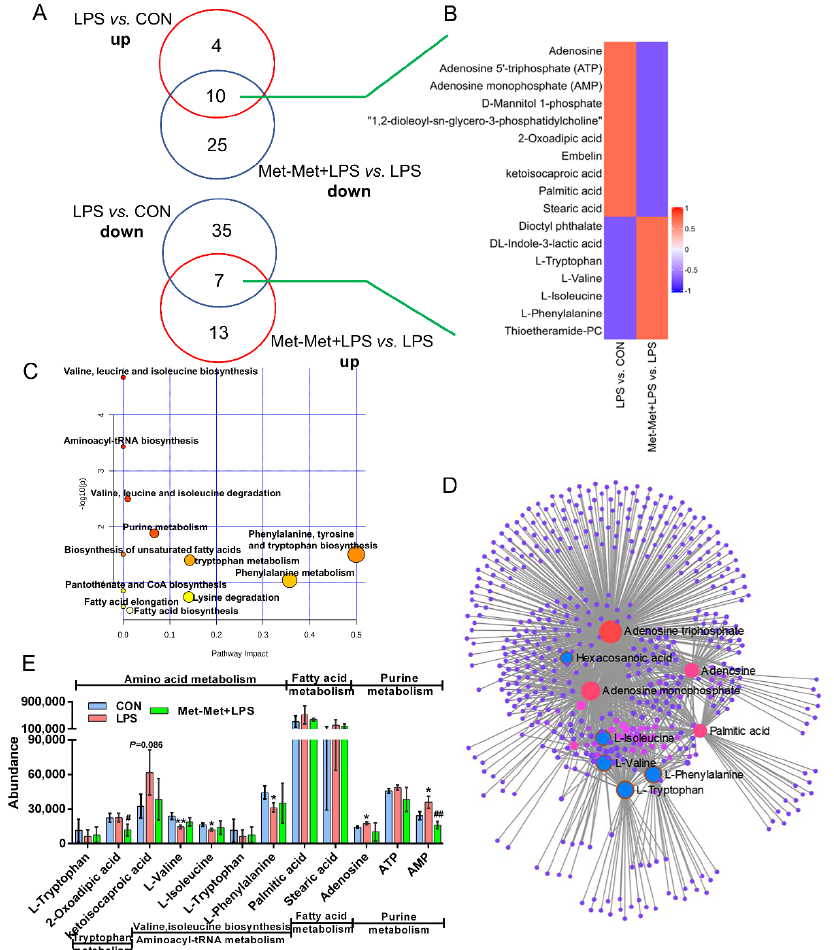
Figure 5. Overlapping metabolites and pathways regulated by inflammation and Met-Met. ( A ) Venn diagrams represent the DMs from two comparative groups of LPS vs. CON and Met-Met+LPS vs. LPS. ( B ) Heatmap of 17 overlapping metabolites. ( C ) Pathway analysis of 17 overlapping metabolites. The X -axis and Y -axis indicate the pathway impact and the degree of pathway en- richment, respectively. A darker color indicates a higher degree of pathway enrichment, and a larger size indicates a higher pathway impact value. ( D ) Metabolite-metabolite interaction net- work of overlapping metabolites. Node size represents the degree. The red circle represents the overlapping metabolites that were notably increased by LPS and further decreased by Met- Met. The blue circle corresponding to the overlapping metabolites was reduced in the LPS group and further upregulated by Met-Met. ( E ) The classification map of overlapping metabolites. * p < 0.05 and ** p < 0.01, represent the difference between LPS and CON group; # p < 0.05 and ## p < 0.01 denote significance between the Met-Met+LPS and LPS groups; DMs: differential